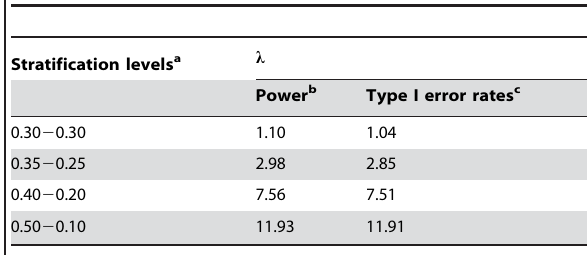
Table 2. Average corrector factor l estimated by GC in populations with various stratification